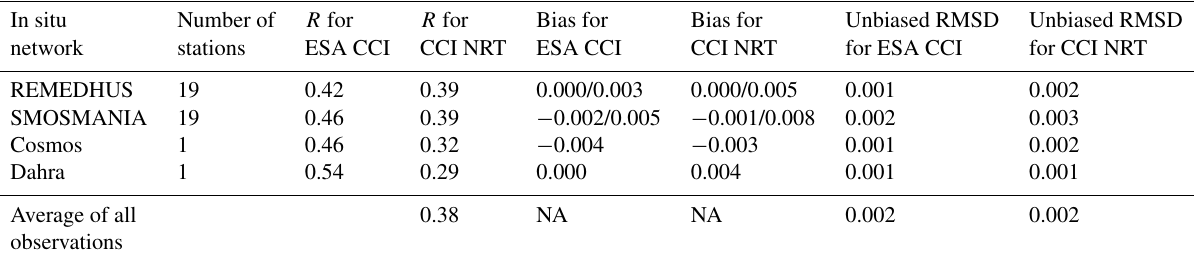
Table 2. Statistical scores for ESA CCI SM/CCI NRT anomalies and in situ stations/networks (maximum depth 0.1m) in Spain, France, Kenya and Senegal for 2013 (for the REMEDHUS and SMOSMANIA networks the table includes the bias range from minimum to maxi-